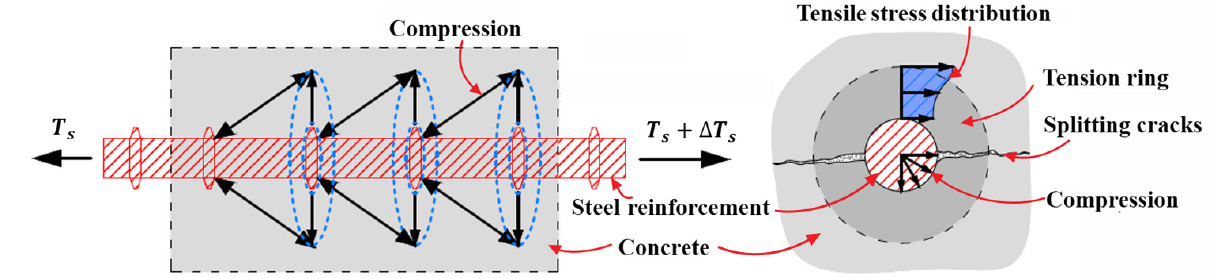
Figure 4. Tensile stress distributed in concrete and splitting cracks induced by bond action of steel reinforcement.